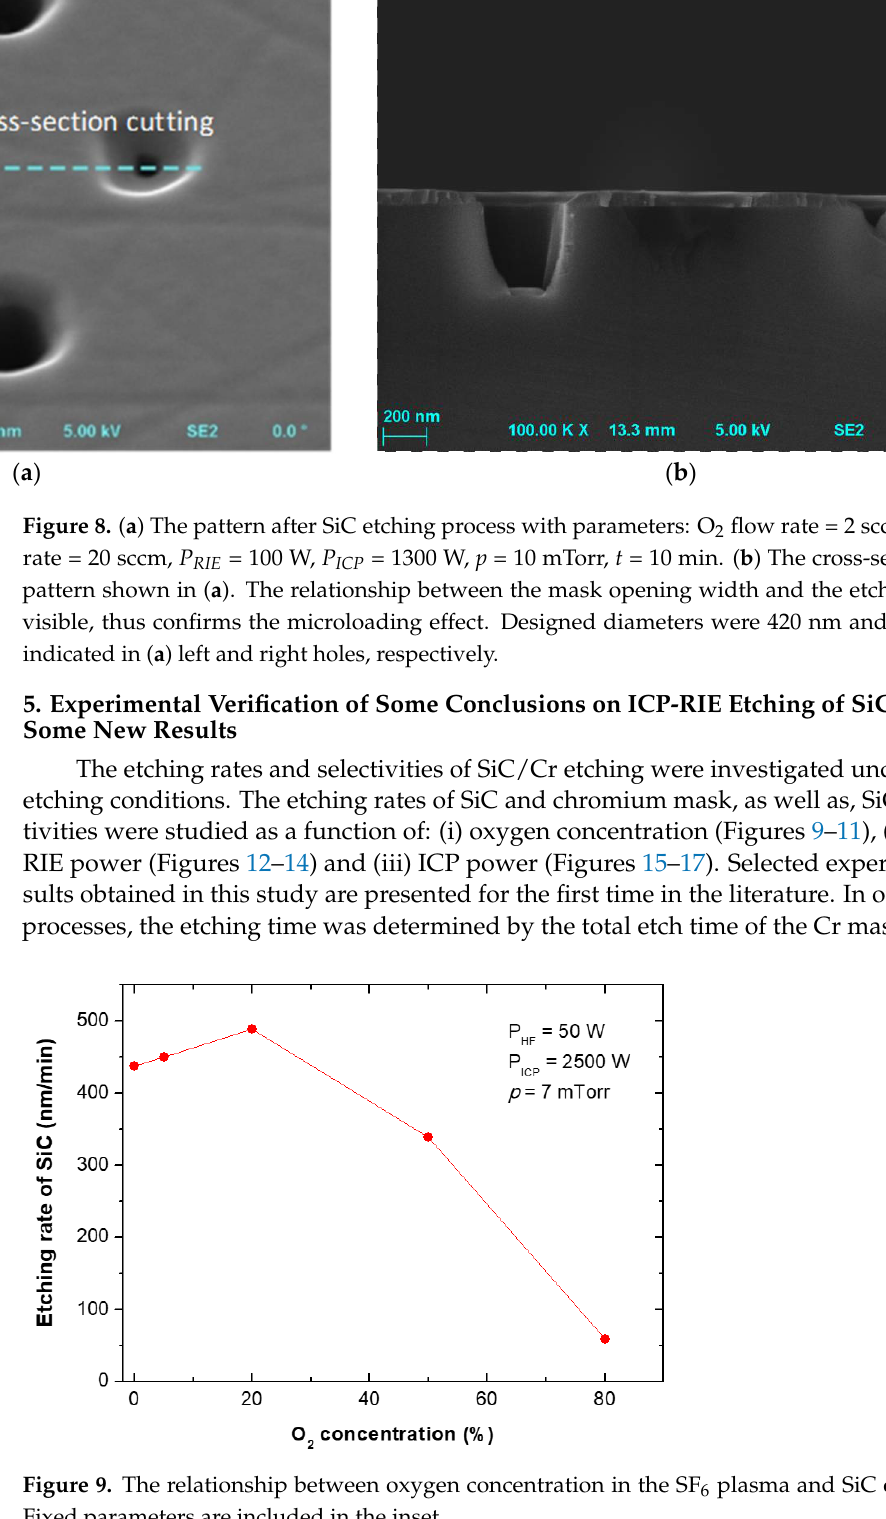
Figure 10. The relationship between oxygen concentration in the SF 6 plasma and the Cr mask etching rate. Fixed parameters are included in the inset.